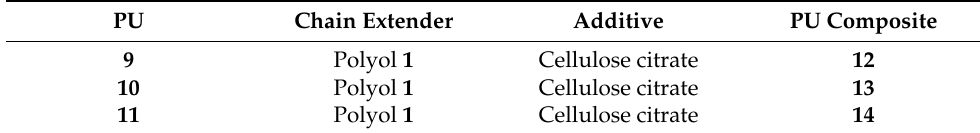
Table 1. Polyurethane composite materials 12–14.